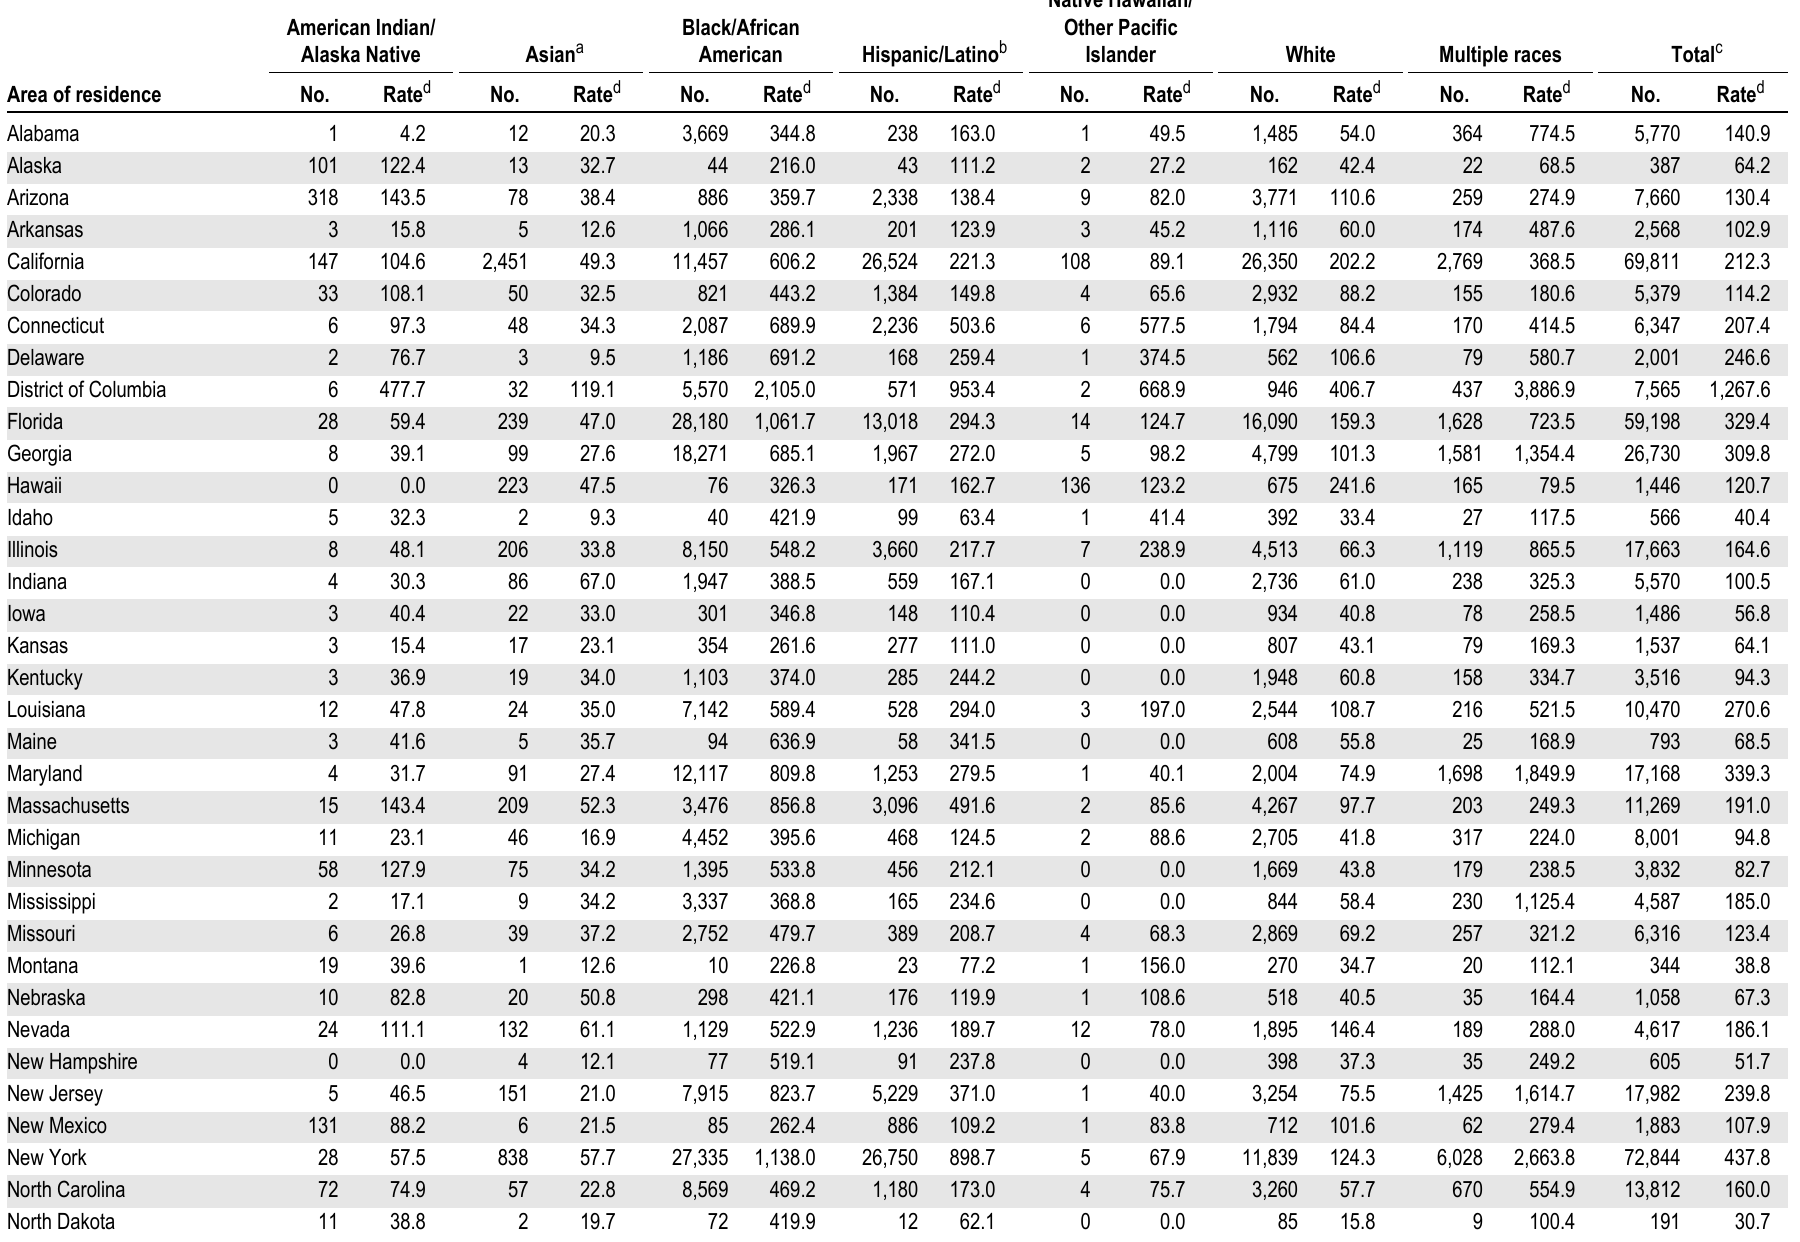
Table 29. Adults and adolescents living with diagnosed HIV infection ever classified as stage 3 (AIDS), by race/ethnicity and area of residence, year-end 2017—United States and 6 dependent areas American Indian/ Alaska Native Asian